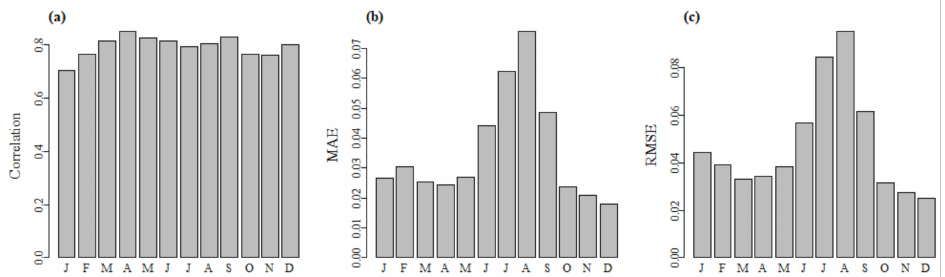
Figure 9. Per-image accuracy for the Landsat-8 test data: ( a ) correlation; ( b ) MAE and ( c ) RMSE. Errors in any one image occur when there are too many missing cloud-free images in the NDVI sequence. For example, in 2014 there were no Landsat-7 images available from June to mid-August. As a result, SWGC failed to adequately estimate maximum NDVI for some cells. This is shown in Figure 10. Compared to the observed NDVI for 2014-08-15 (Figure 10a), the predicted NDVI (Figure 10b) was too high during the season’s peak in some areas, as shown in Figure 10c. Figure 10d shows the time series of observed and predicted data for a typical cell where this occurred. The full dynamics of the NDVI time-sequence can be seen in Supplementary Materials 2.